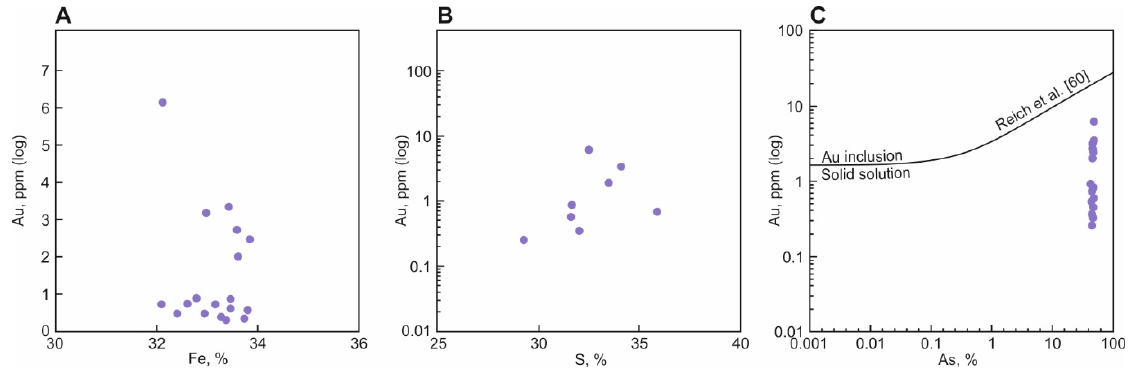
Figure 13. Binary correlation diagrams for Ару 1: ( A ) Fe vs. Au; ( B ) Au vs. S; ( C ) As vs.